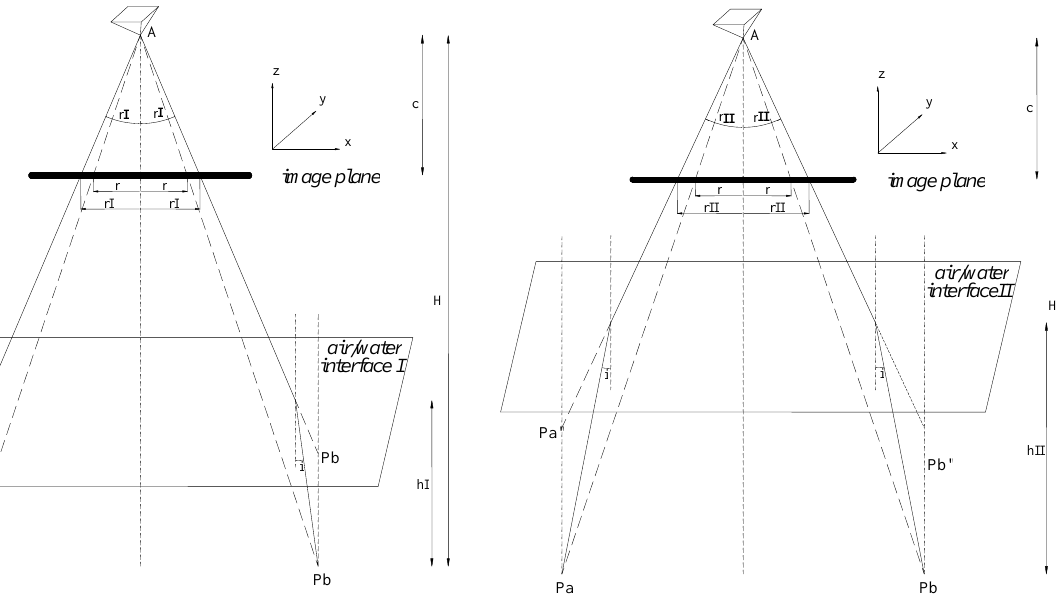
Figure 2. The two-media Photogrammetry geometry for an Figure 3. The two-media Photogrammetry geometry for an air/water interface II, in a higher level than